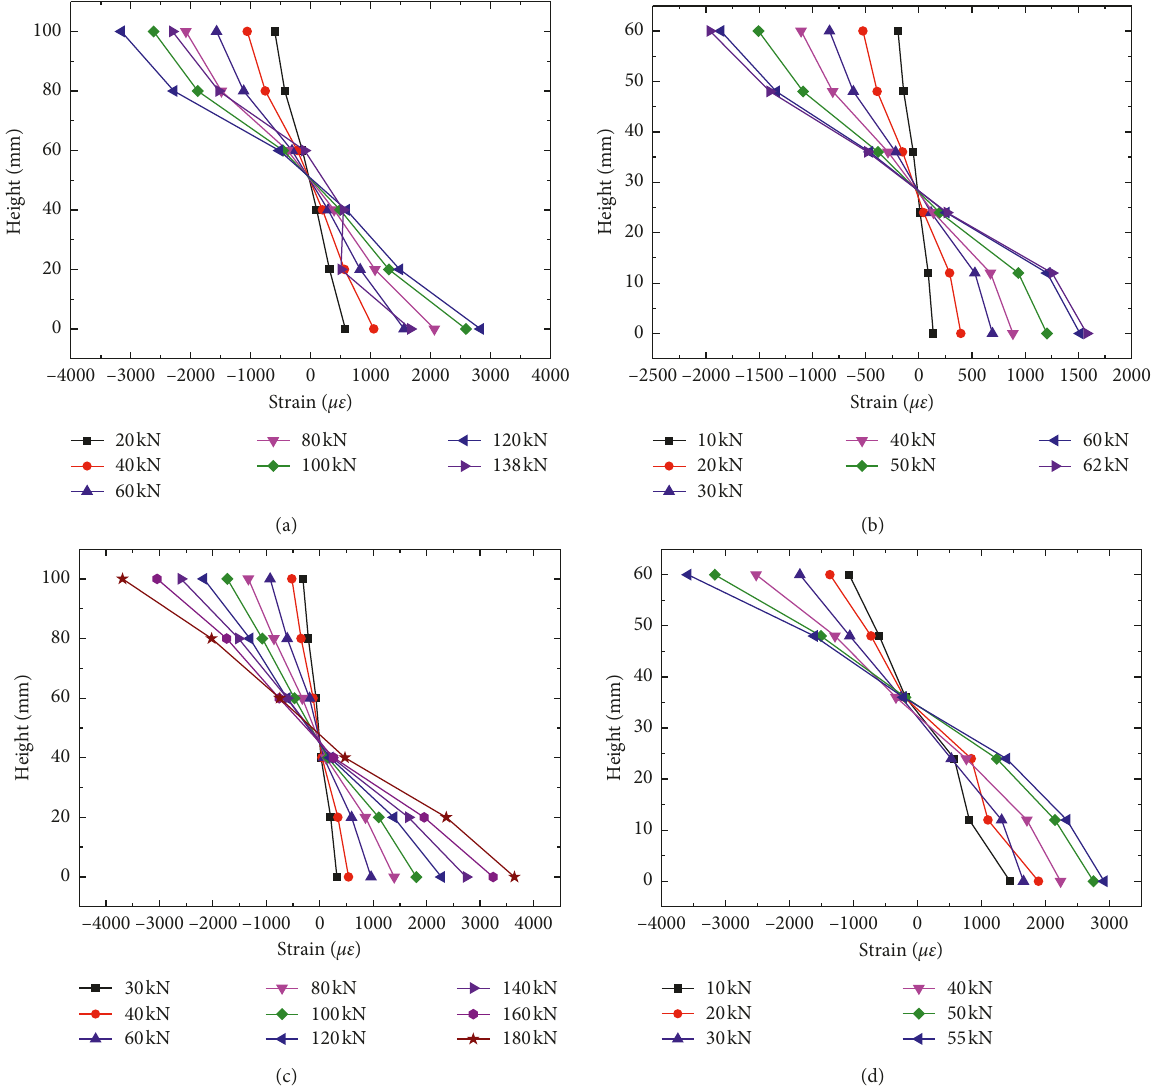
Figure 20: Strain distributions along slab thickness at midspan. (a) CLB-A3. (b) CLB-C1. (c) CLB-I2. (d) CLB-M1.